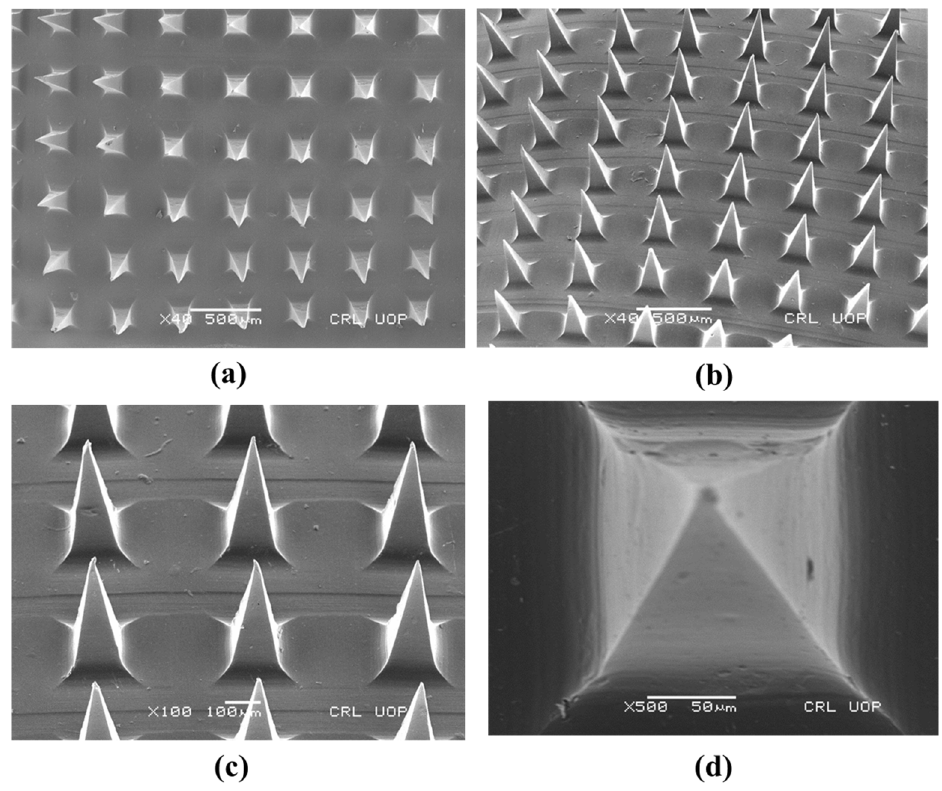
Figure 3. SEM photomicrographs of F26 at different magnification powers ( a ) × 40, ( b ) × 40 (aerial view), ( c ) × 100 (side view) and ( d ) × 500.